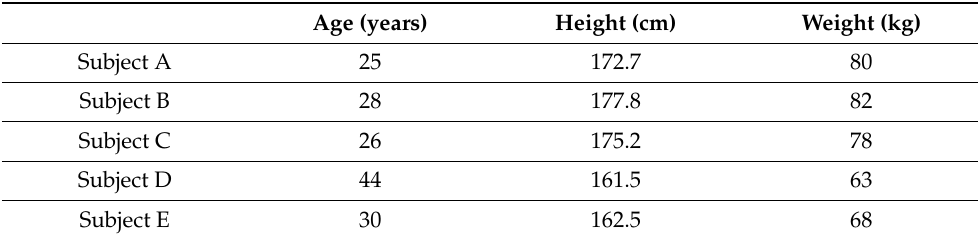
Table 4. Healthy human subject